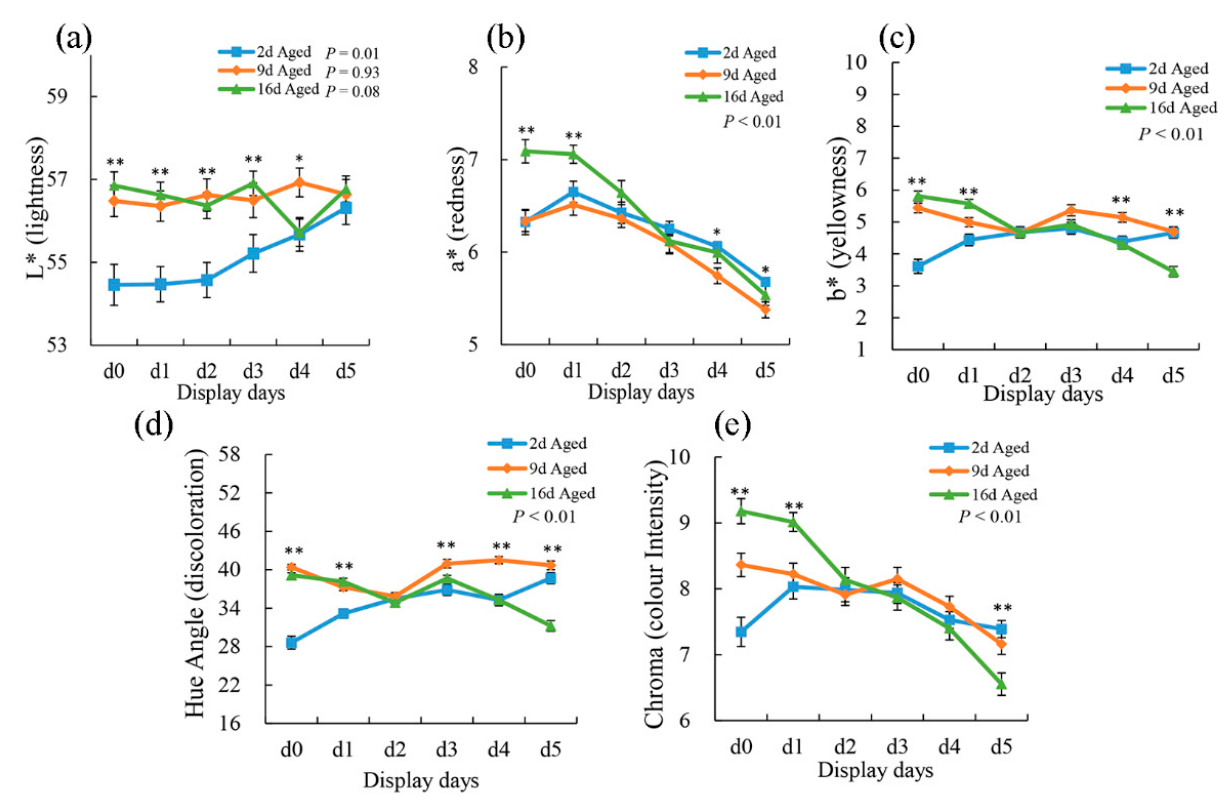
Figure 1. The effect of aging on the changes in L* ( a ), a* ( b ), b* ( c ), hue angle ( d ), and chroma ( e ) of pork steak during 5 days of display. The results are expressed as the mean ± standard error. The significant differences among three aging treatments at the same display time were marked with asterisks (* means p < 0.05; ** means p <